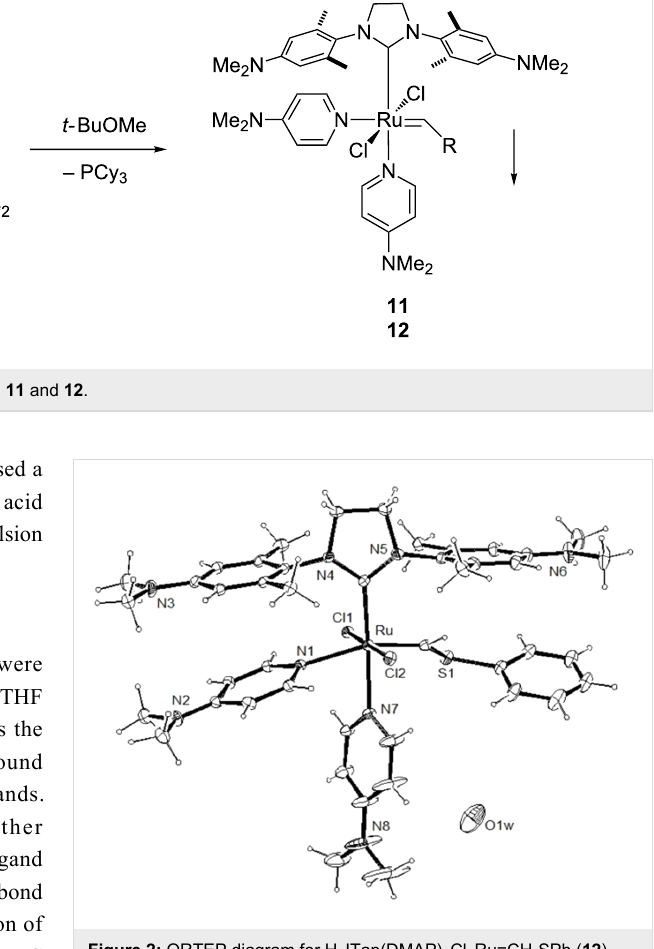
Figure 2: ORTEP diagram for H 2 ITap(DMAP) 2 Cl 2 Ru=CH-SPh ( 12 ). The positions of the hydrogen atoms were calculated. The unit cell contains a molecule of cocrystallized water. The hydrogen atoms of the water molecule were omitted from the structure due to thermal